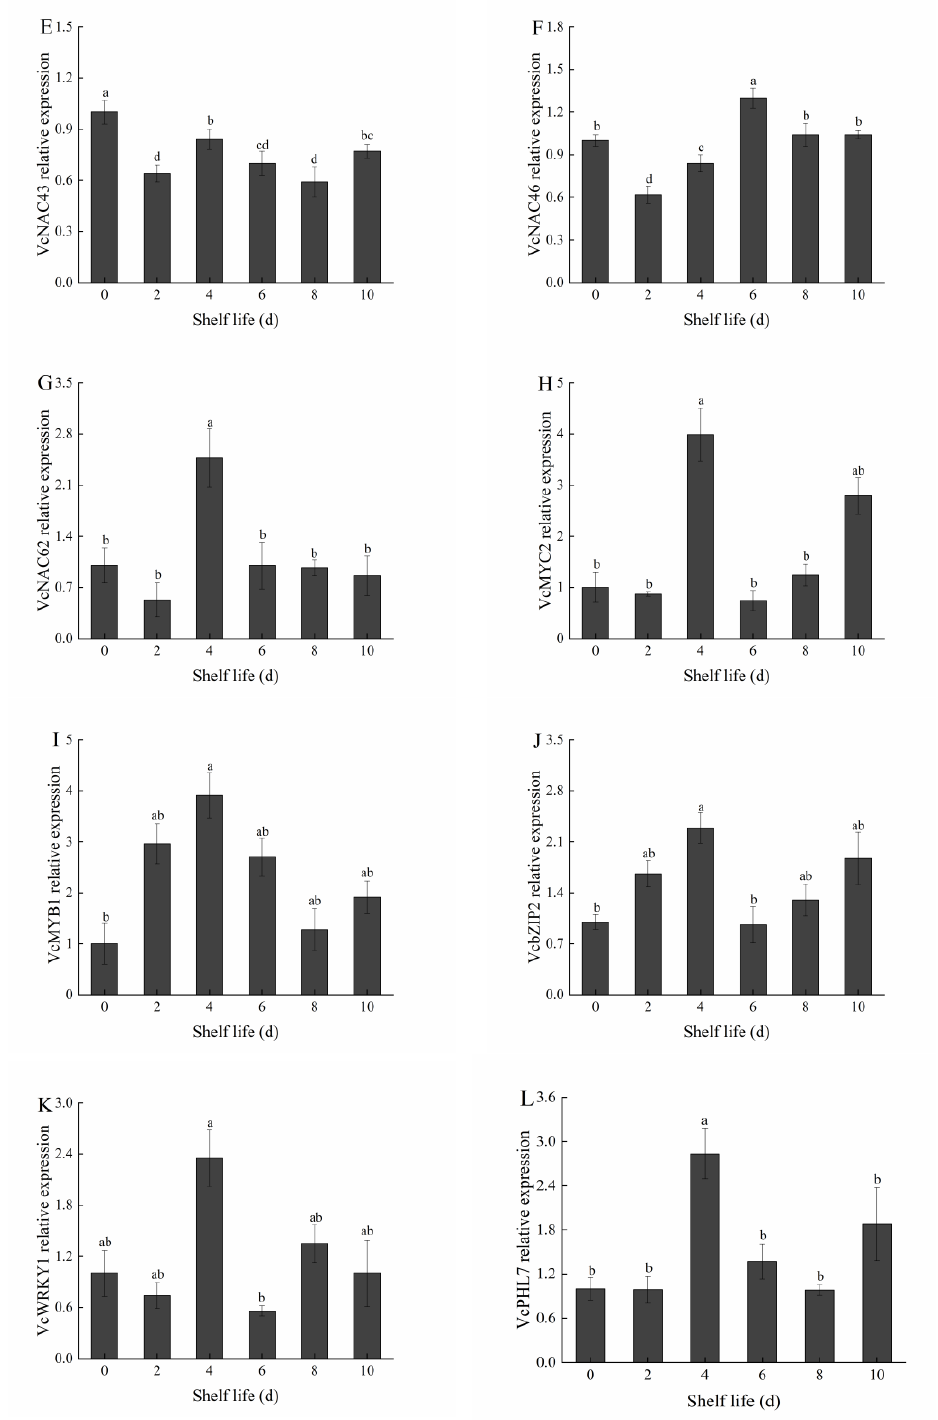
Figure 13. Predicted changes in VcNAC26 ( A ), VcNAC23 ( B ), VcNAC33 ( C ), VcNAC35 ( D ), VcNAC43 ( E ), VcNAC46 ( F ), VcNAC62 (G ), VcMYC2 ( H ), VcWRKY1 (I ), VcMYB1 ( J ), VcbZIP2 ( K ) and VcPHL7 ( L ) relative expressions in blueberry fruit after harvest at 20 °C. Mean ± SE of three replicate experiments are shown. Different letters represent significant differences ( p < 0.05).